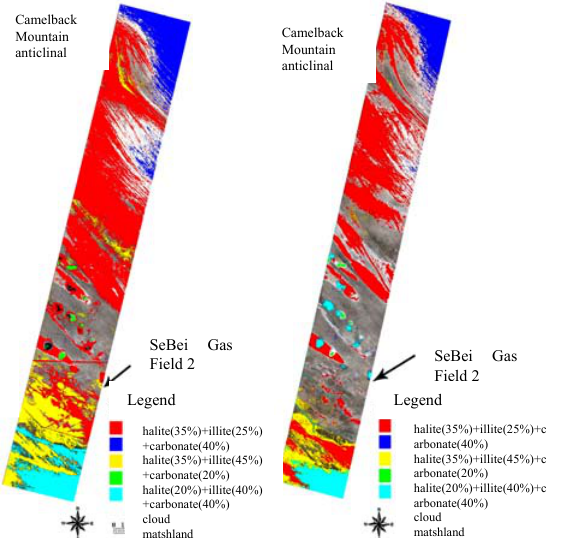
Figure 3. Identification results of alteration minerals with SAM Figure 4. Identification results of alteration minerals with LUC